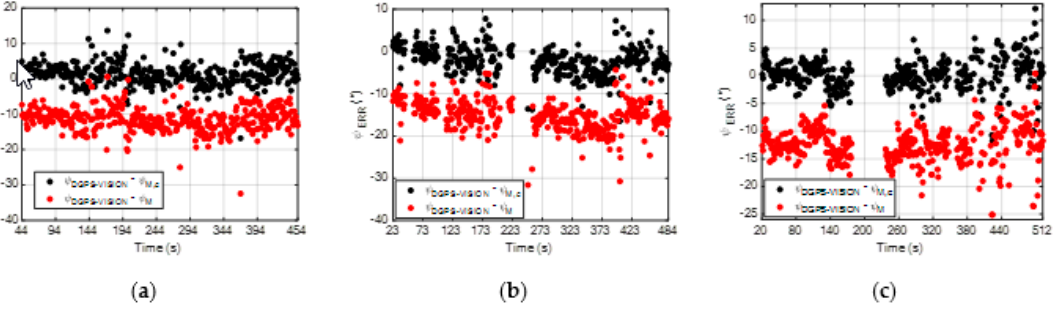
Figure 10. Time variation of ψ ERR for the calibrated ( ψ M,c ) and non-calibrated ( ψ M ) magnetic heading during the three flight tests conducted with a flying deputy. ψ M,c is obtained applying (6) with the values of the magnetic bias vector components obtained from the calibration results described in Section 3.1.2, i.e., Δ Hx S = − 267.53, Δ Hy S = − 4.17. ( a ) Flight test 1; ( b ) Flight test 2; ( c ) Flight test 3.